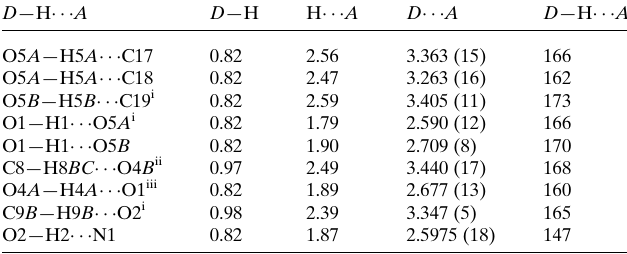
Table 1 Hydrogen-bond geometry (A˚ , (cid:3) ).